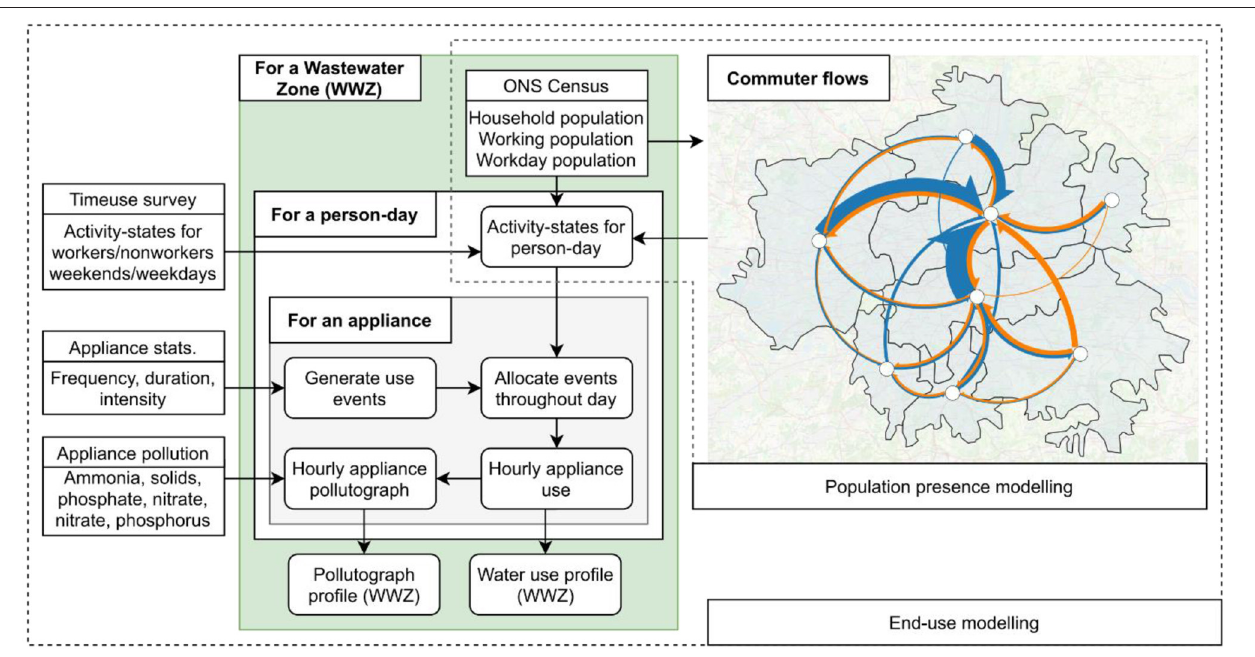
FIGURE 3 | A flow chart demonstrating the key stages in the end-use modelling. The map depicts commuter flows between the eight wastewater zones in London. Flows with fewer than 5,000 people/day are not shown. Only commuting between zones is depicted for visibility, however commuting into/out of London is captured by the model. Arrow width is proportional to number of people per day, with the largest flow being 500,000 people/day. Arrows are coloured to highlight direction of flow.